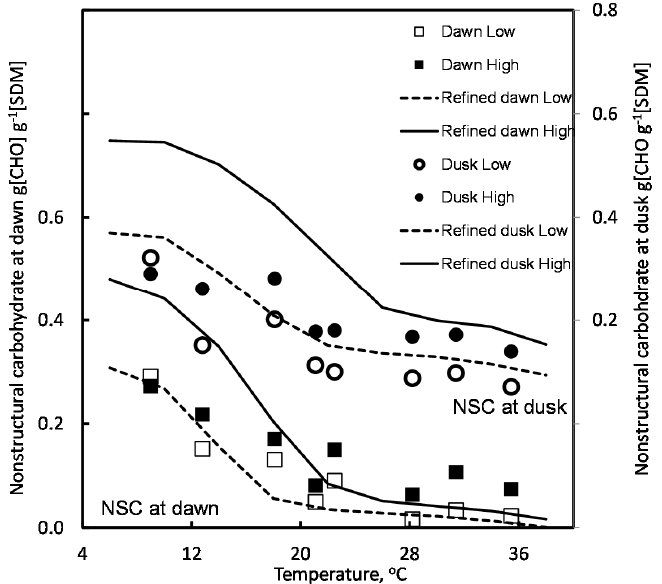
Figure 5. Non ‐ structural carbohydrate at dusk and dawn in tomato seedlings grown over a range of temperatures under low or high light, averaging 110 or 370 μ mol[PAR] m − 2 s − 1 [30]. Values are offset for dusk and dawn. Symbols represent observed NSC. Predictions are from the dynamic model using parameter values as specified for the refined model, lines.